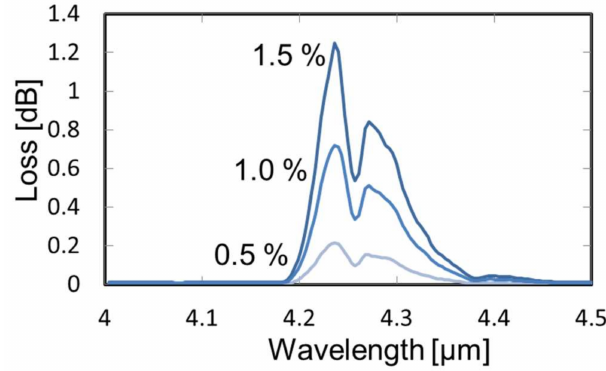
Figure 6. Absorption loss spectra of CO 2 gas with different concentrations measured by the FT-IR-based gas analysis system.